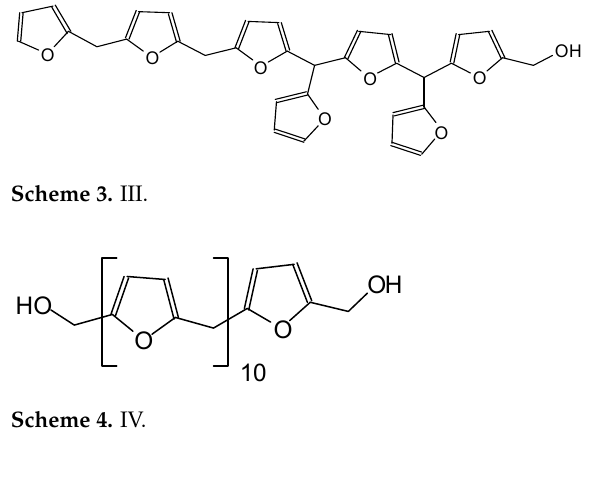
Figure 15. CP MAS 13 C NMR spectra of untreated beech wood and beech wood heat-treated at 230 °C in the 110–180